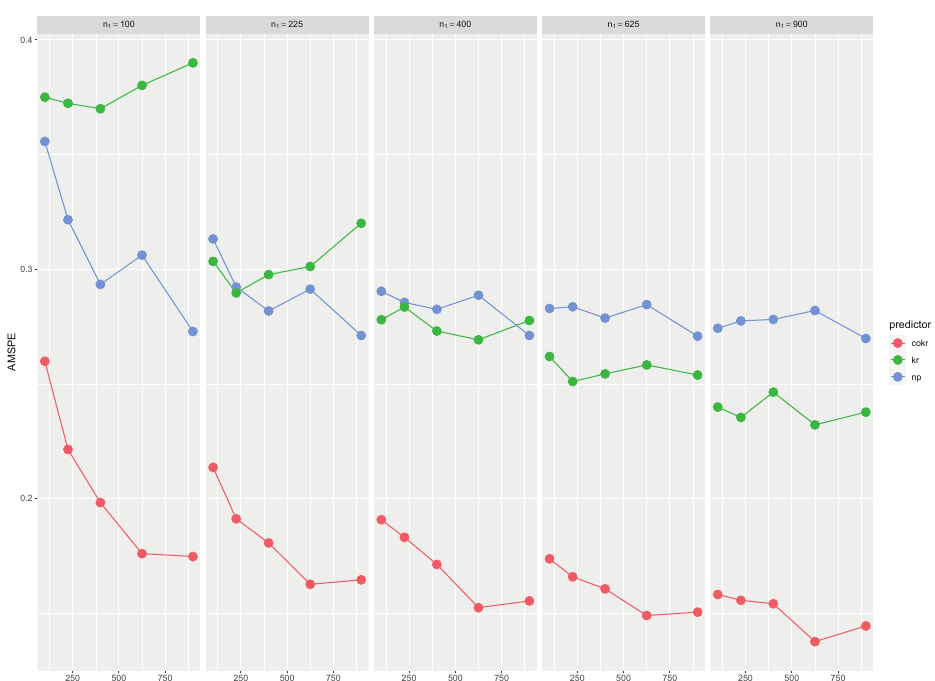
Figure 1. Plots of the AMSPE values obtained for several sample sizes n 1 and n 2 and correlation ρ 12 ( 0 ) = 0.99, for data drawn from random fields Z 1 and Z 2 with constant trends, derived from Gaussian processes V 1 and V 2 with nugget and spherical semivariograms, respectively. For implementation of the kriging and cokriging approaches, the dependence structures of V 1 and V 2 were estimated through the theoretical